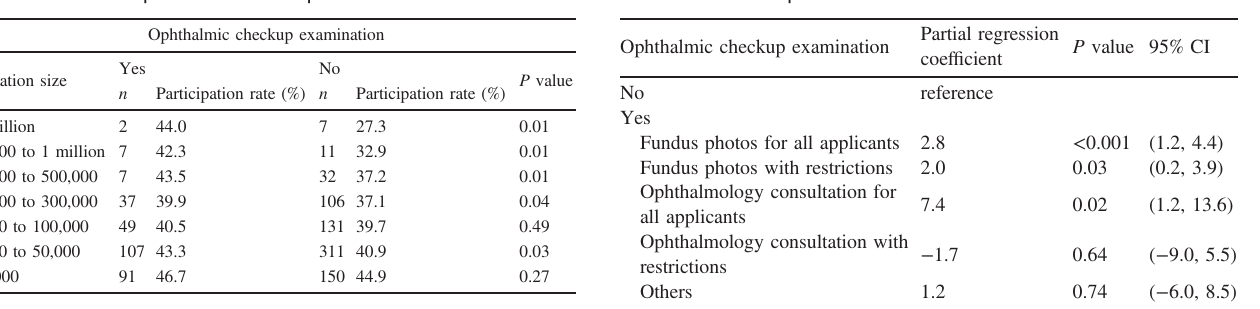
Table 4. The association between the speci fi c health checkup participation rate and the procedures of the